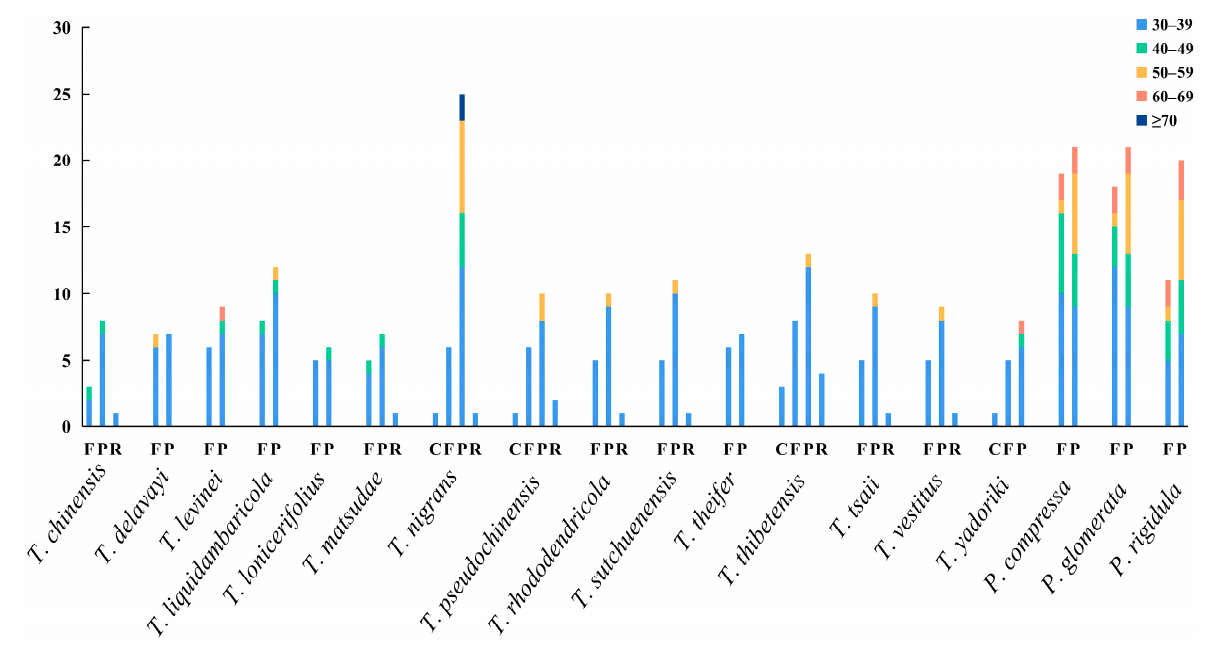
Figure 4. Long repeats of the chloroplast genomes of Taxillus and Phacellaria species . Simple sequence repeats (SSRs), which are also referred to as microsatellite se- quences, can be found extensively throughout chloroplast genomes [65]. Due to its high polymorphism, it is increasingly used as molecular markers, species identi fi cation, popu- lation genetics, and phylogeny [66–68]. A total of 45 ( T. levinei )–87 ( T. thibetensis ) SSRs were detected in the chloroplast genomes of Taxillus species, and 40 ( P. compressa )–43 ( P. rigid- ula ) SSRs were detected in Phacellaria species (Supplementary Tables S3 and S4). The most common mononucleotide repeats were A/T and most dinucleotide repeats were AT/AT. Most SSRs were rich in A/T, which was greatly related to the high A/T content in the chlo- roplast genome. Moreover, polyA and polyT occupies a relatively high proportion in the SSRs of many plants, compared with polyC and polyG [69].